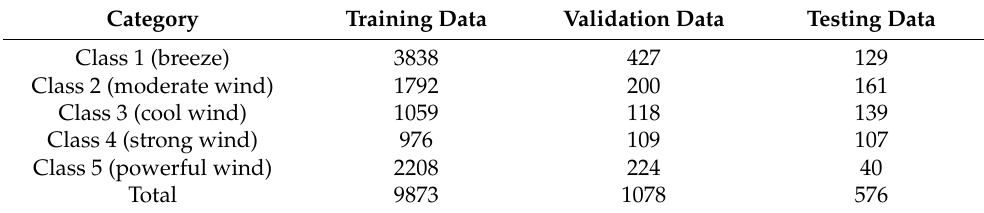
Table 4. The number of data points that are used for every category.